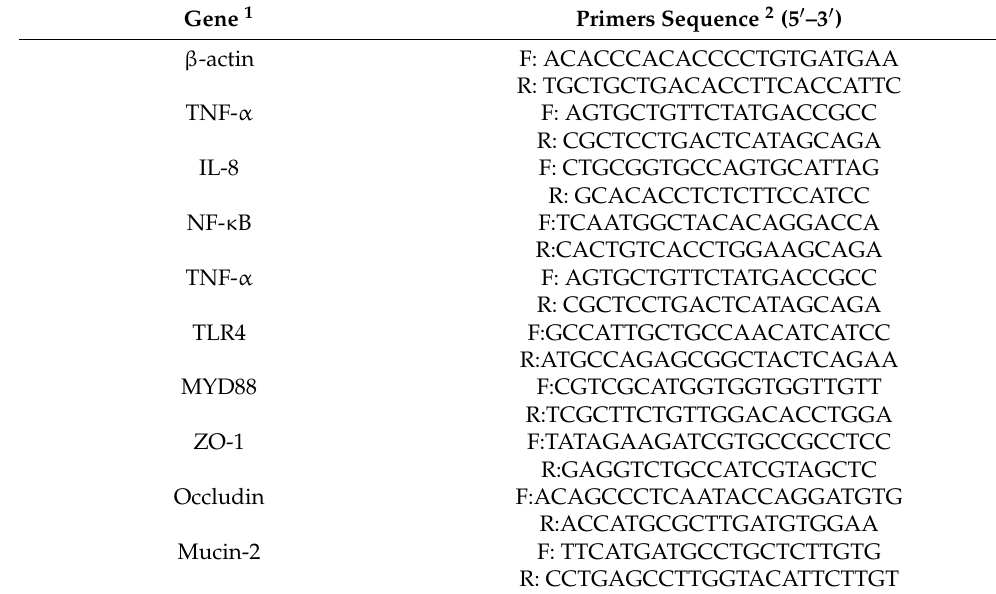
Table 2. Primers used for quantitative real-time PCR in this study. Gene